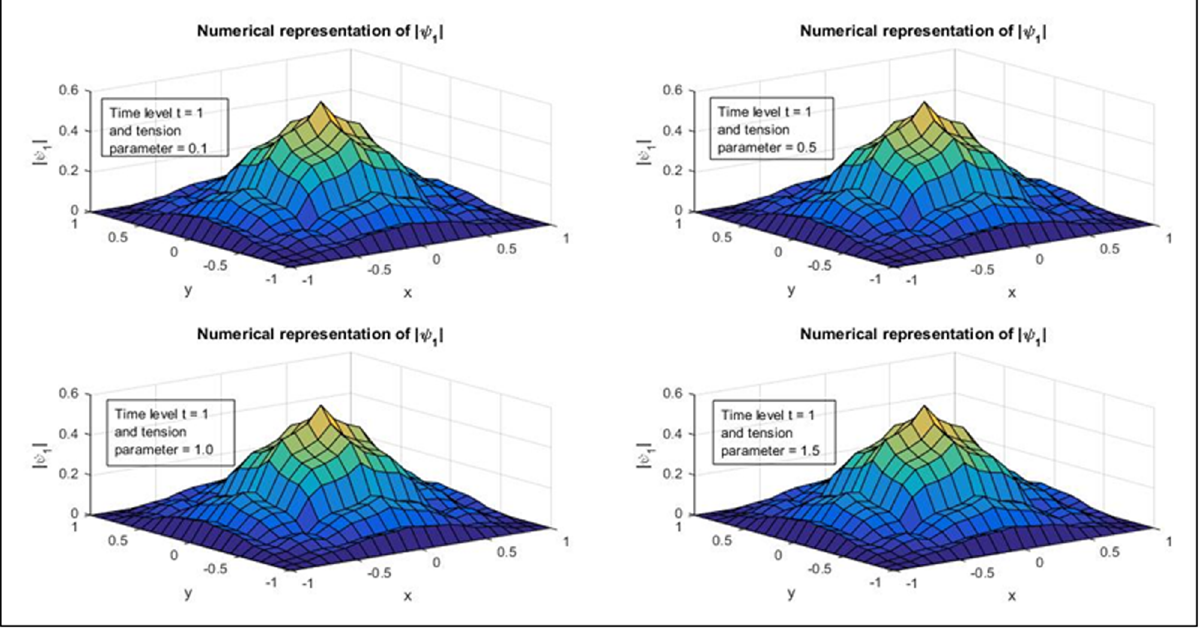
and for di ff erent values of tension parameters. In Figure 16, contour representation of numerical solution of second - wave amplitude is shown at t 1 = and for dif - ferent values of tension parameters.